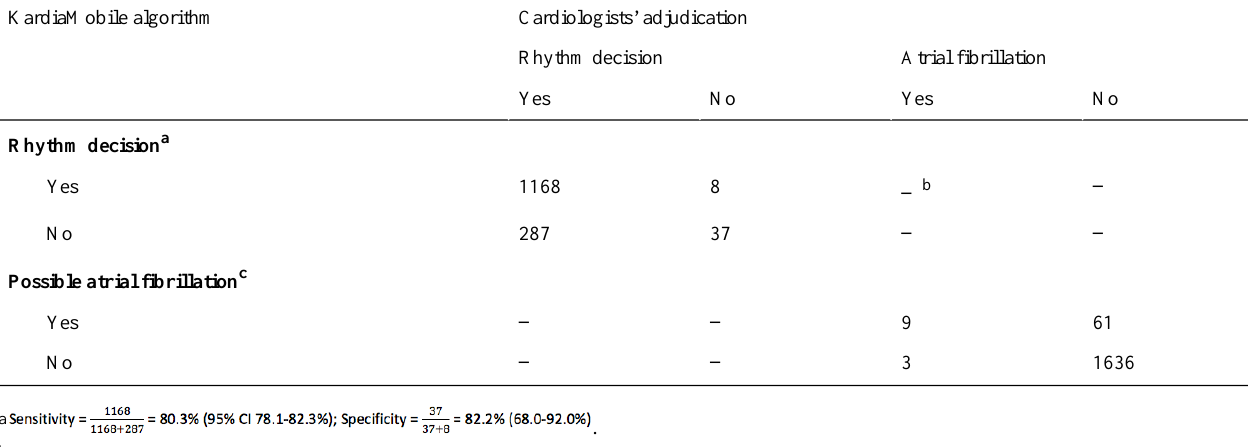
Table 2. KardiaMobile automated algorithm versus cardiologists’adjudication for single-lead electrocardiogram (ECG) for rhythm decision in n=1500 participants and atrial fibrillation detection in n=1709 ECG